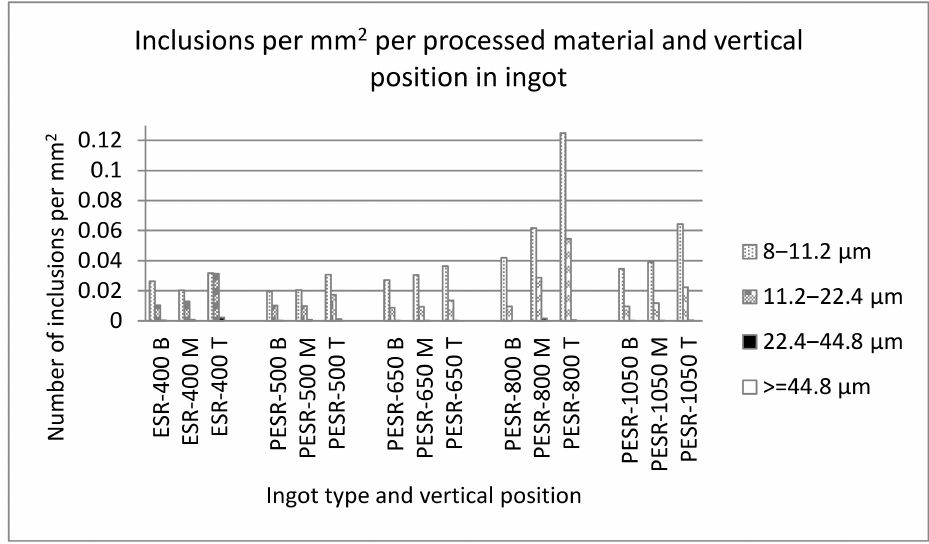
Figure 10. Number of oxide inclusions per mm 2 and ingot size and from the electrode and the processed material from the ingots (after approximately a 75% reduction) at different axial positions. Electro-slag remelted ingot 400 × 400 mm 2 (ESR-400) and pressure electro-slag remelted ingots 500–1050 mm in diameter (PESR-500, PESR-650, PESR-800, and PESR-1050) at bottom (B), middle (M), and top (T) positions. No inclusions > 44.8 µ m were detected in the processed